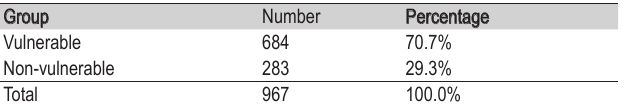
Table 3 - Results of discriminant analysis using data of 992 study participants in Ile-Ife.